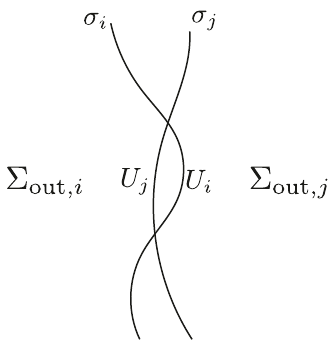
Figure 4 . If two outermost minimal surface were to “weave” through each other, we would have a contradiction since either ( σ area less than σ